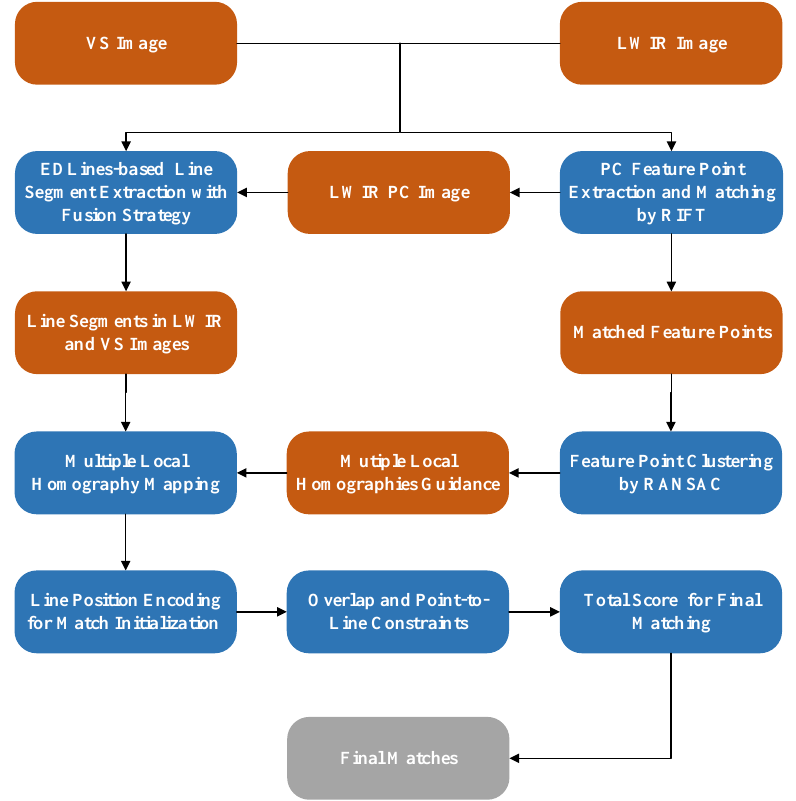
Figure 2. Workflow of the proposed multispectral line segment matching method (data, algorithms, and results are enclosed in orange, blue, and grey boxes,